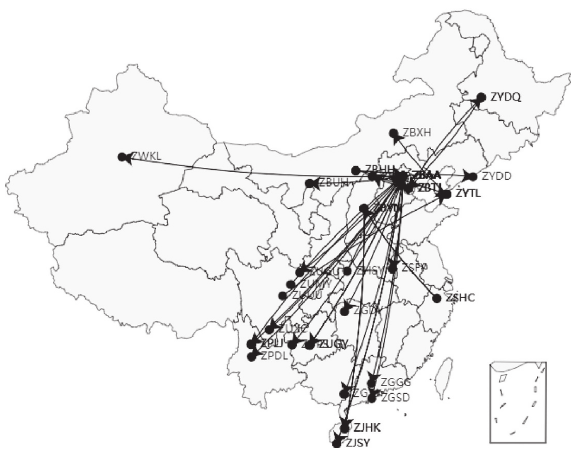
Figure 6: Flight routes requested by CCA for the adjustment of flight block time.